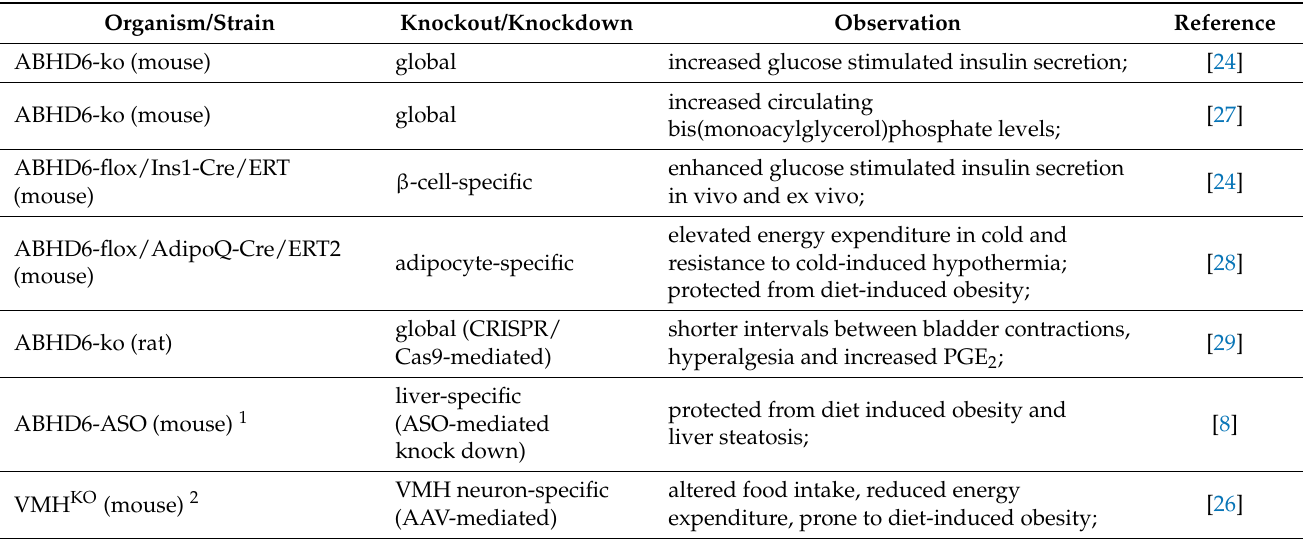
Table 1. Mouse and rat lines with global or tissue-specific deletion of